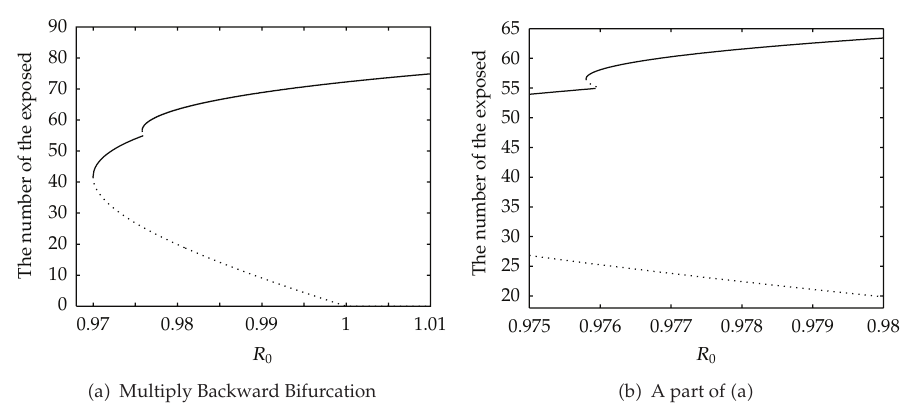
Figure 5: Double backward bifurcations of model (cid:2) 3.10 (cid:3) . Dotted lines represent unstable equilibria, and solid lines represent stable